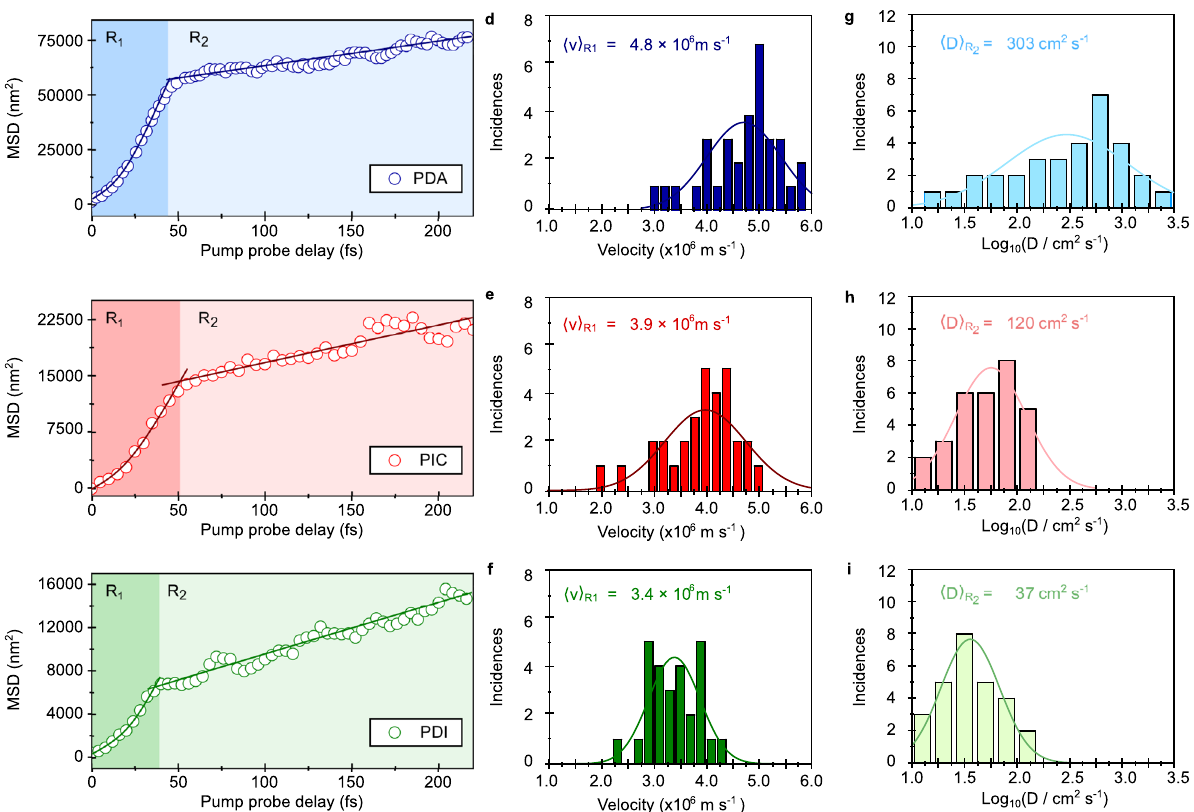
(cid:3) (cid:4) 2 ) as a function of time for